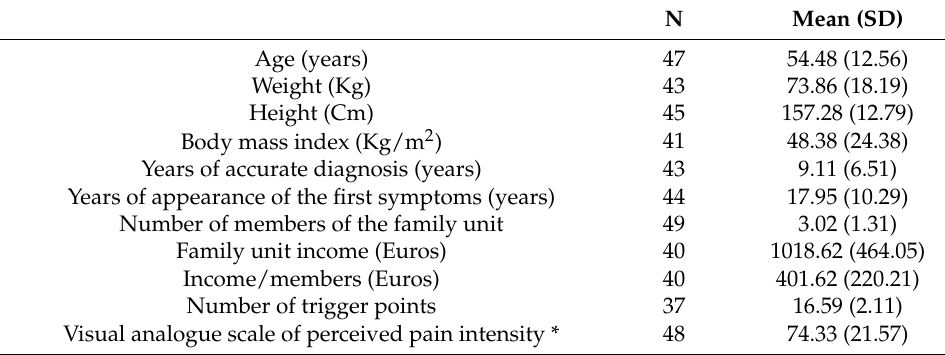
Table 2. Sociodemographic characteristics of FM